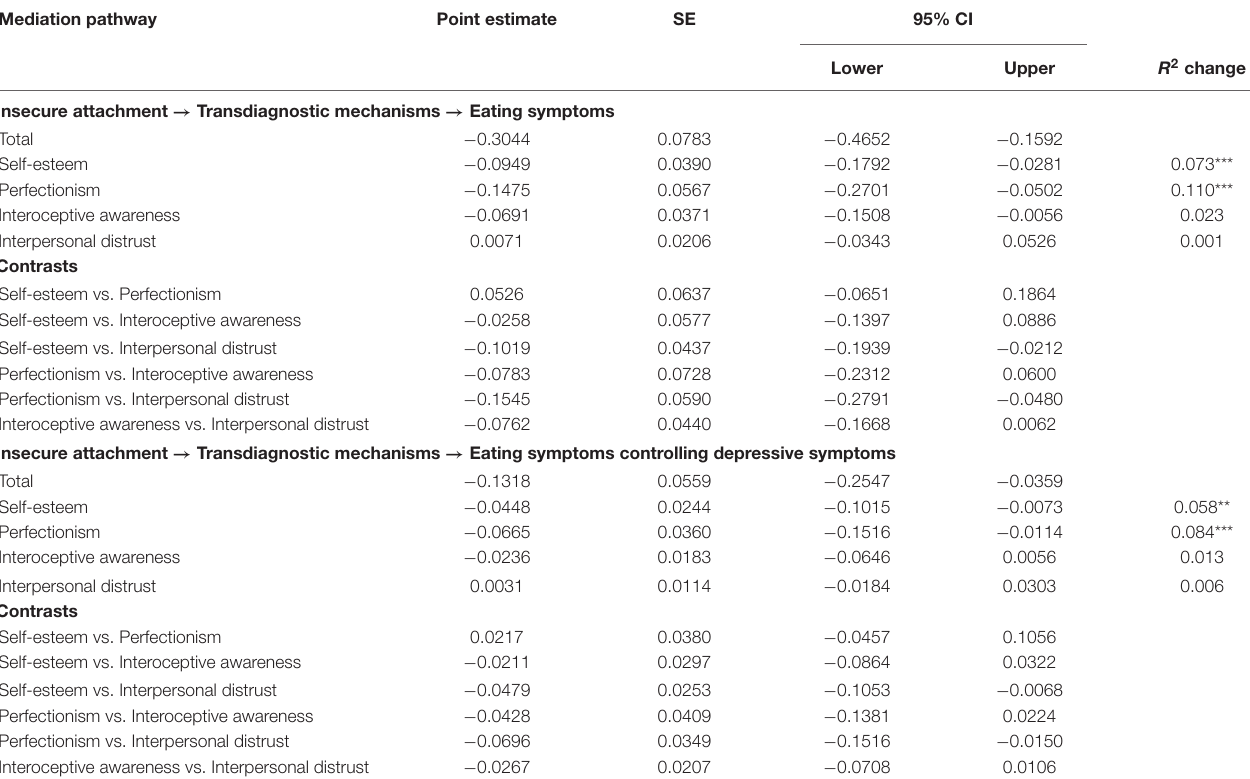
TABLE 3 | Results of multiple mediation analyses of the effect of attachment on eating disorder